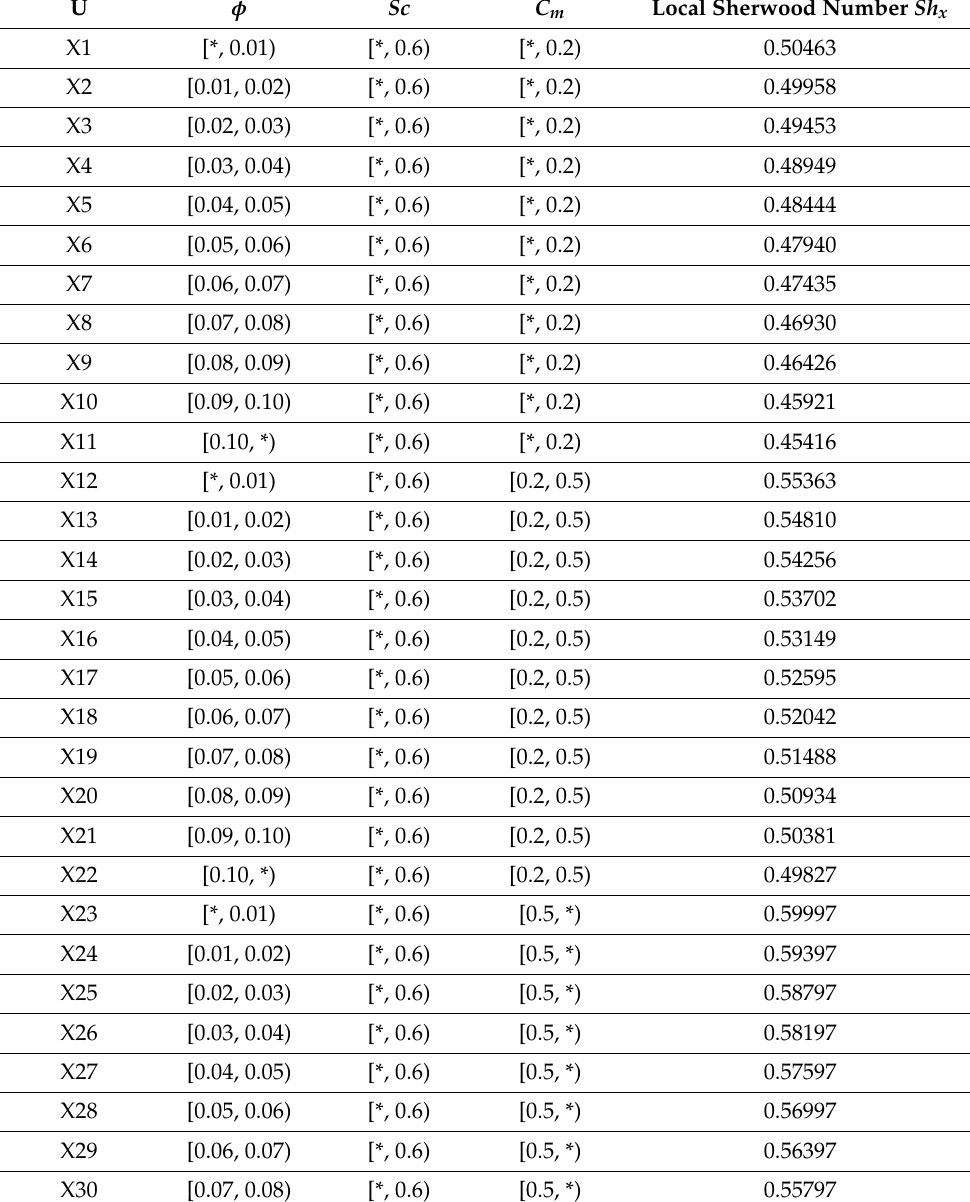
Table 4. The discretized decision table of Table